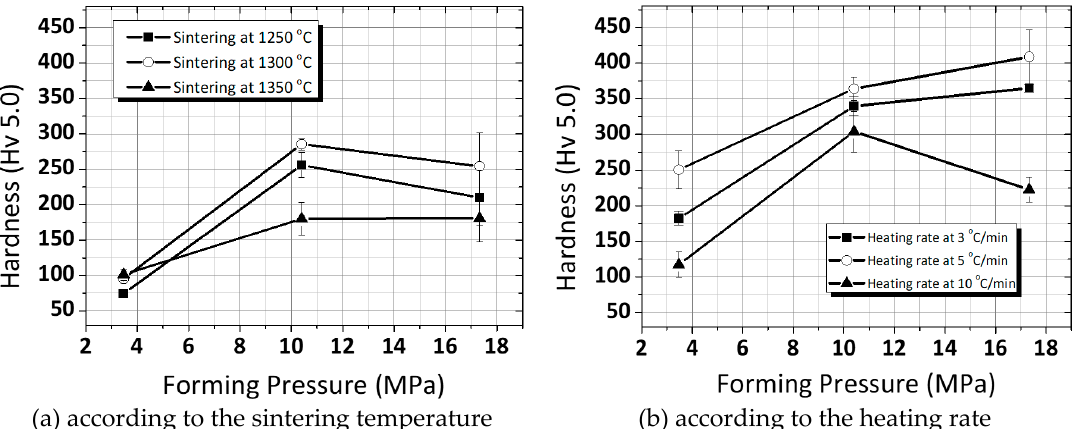
Figure 5. Vickers hardness of the ring-type PZT ceramics (fixed sintering temperature at 1300 °C): ( a ) in accordance with sintering temperature ( b ) in accordance with the heating rate.